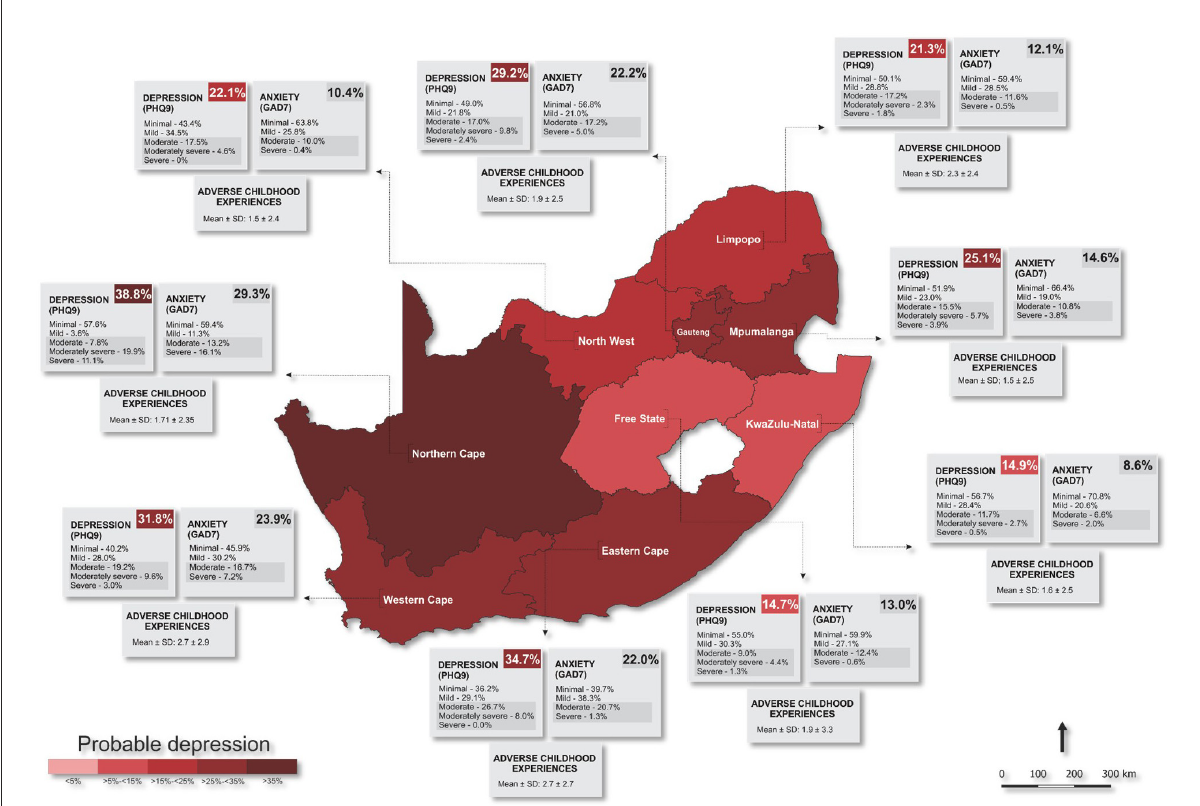
FIGURE3 Prevalence of mental health risk across South Africa. PHQ9, Patient Health Questionnaire; GAD7, Generalized Anxiety Disorder.